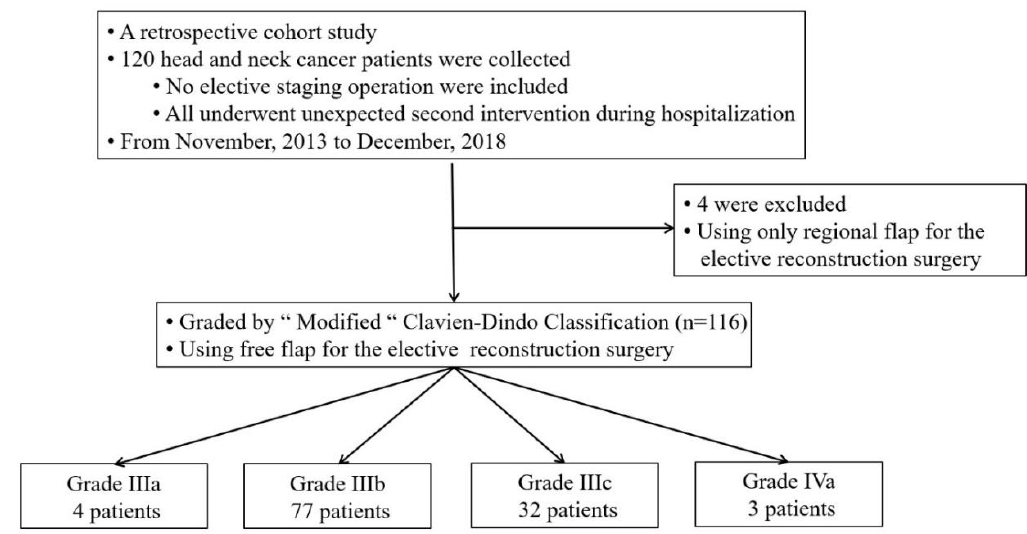
Figure 1. Flowchart of patient enrollment.